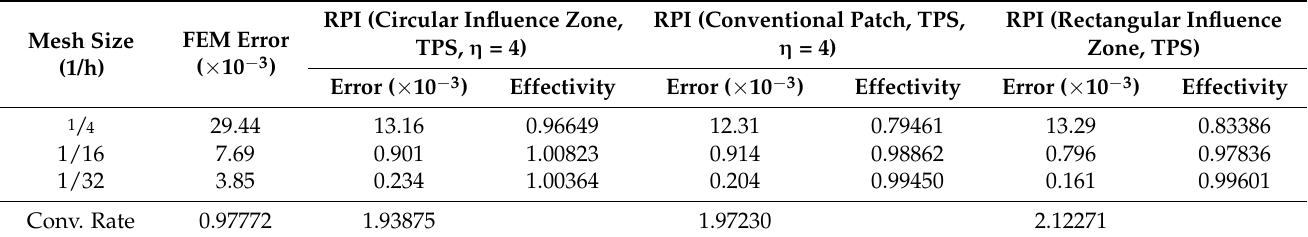
Figure 3. Influence zones for RPI-based error-recovery technique. Figure 3 . Influence zones for RPI-based error-recovery technique. Table 4. Error properties results for RPI (TPS)-based recovery techniques in incompressible-elastic plate analysis considering influence zones and conventional patches (four-node quadrilateral regular mesh).